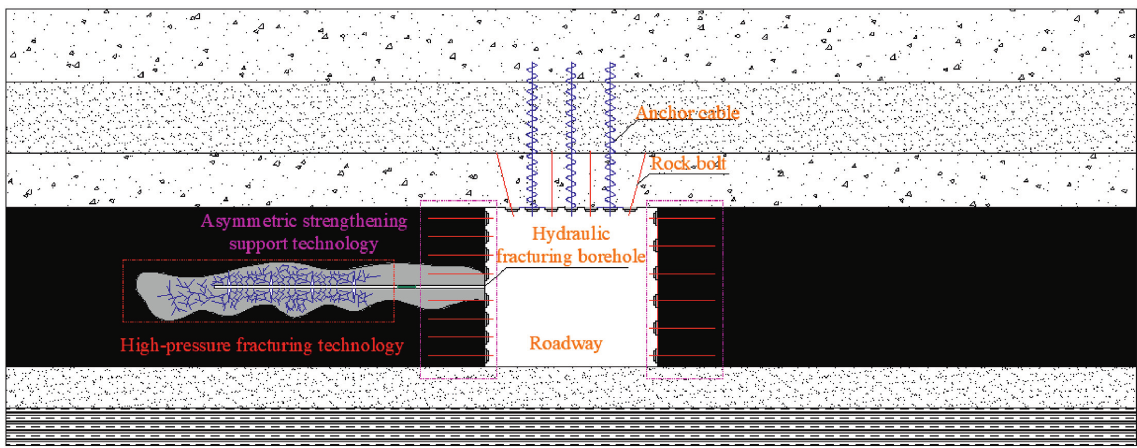
Figure 14: Control technology for surrounding rock.